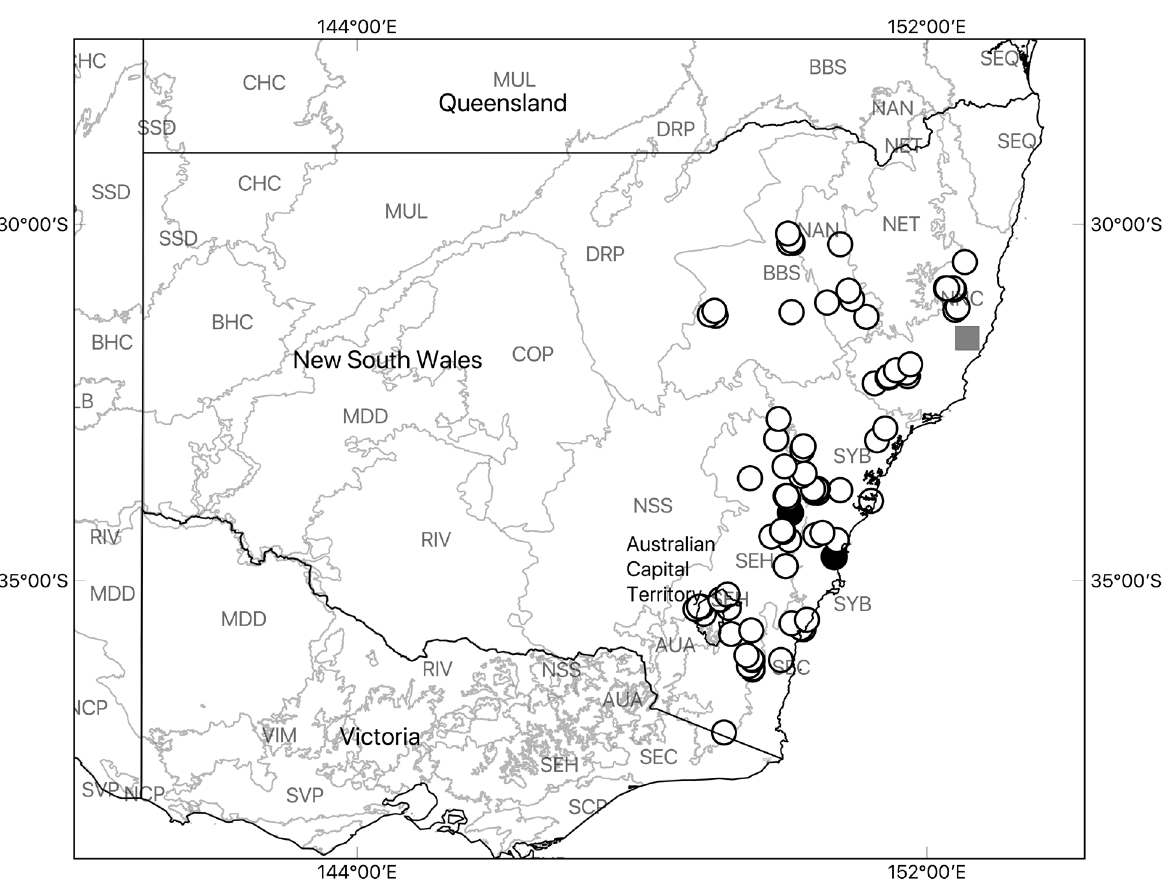
Figure 27. Distribution records of Artoria kanangra sp. n. (full circles), A. kerewong sp. n. (grey square) and A. lineata (L. Koch, 1877) (open circles) in NSW and ACT. IBRA bioregions with spider records: AUA – Australian Alps; BBS – Brigalow Belt South; NAN – Nandewar; NET – New England Tablelands; NNC – NSW North Coast; SEQ – South East Queensland; SEH – South East- ern Highlands; SEC – South East Corner; SYB – Sydney